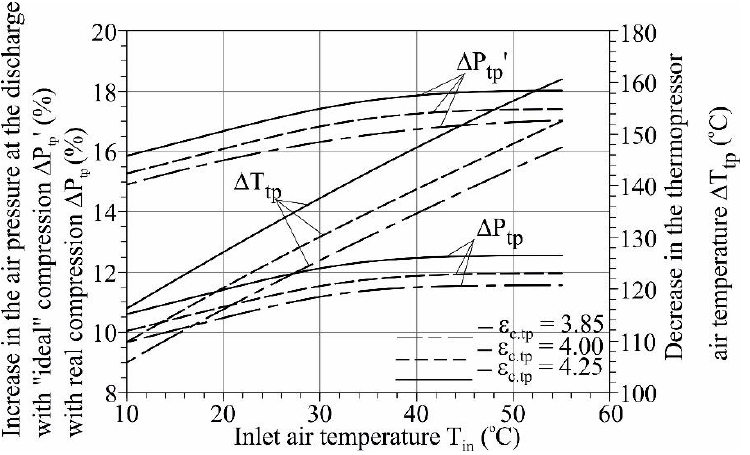
Figure 15. Dependences of the decrease in the thermopressor air temperature, ΔT tp ; an increase in the air pressure at the discharge with “ ideal ” compression, ΔР tp ' (%), and with real compression, ΔР tp (%), at different total pressure increase, ε c . tp , on the inlet air temperature, T in .